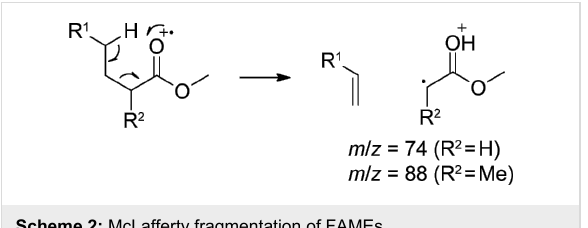
Scheme 2: McLafferty fragmentation of FAMEs.